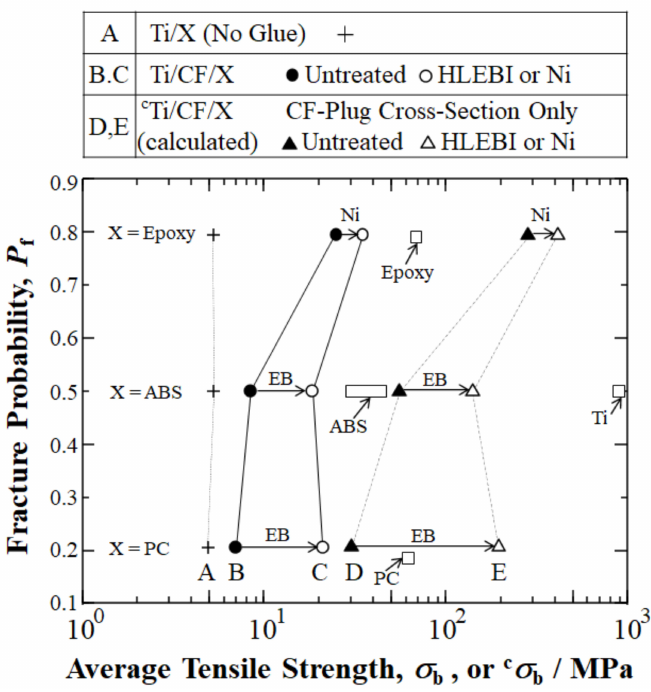
Figure 9. Graphical summary of current status and review showing our previously published results developing Ti/polymer hybrid joints by CF plug insert in terms of fracture probability P f vs. reported average UTS σ b (MPa). Normalized (corrected) c σ b for CF plug cross-sections are shown with data from: Hasegawa, Faudree, Matsumuara, Jimbo, and Nishi (2016) [10]; Hasegawa, Faudree, Enomoto, Takase, Kimura, Tonegawa, Jimbo, Salvia, and Nishi (2017) [11]; and Nishi, Uchida, Faudree, Kaneko, and Kimura (2019) [46], for titanium joints with ABS, PC, and epoxy, respectively, along with σ b of bulk Ti from Barksdale (1968) [80] and data of ABS, PC and epoxy from Shackelford (2000)